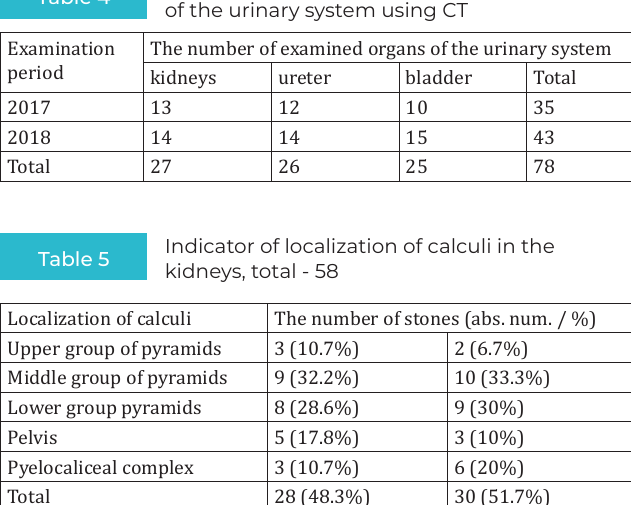
Quantitative indicator of the examined organs of the urinary system using CT